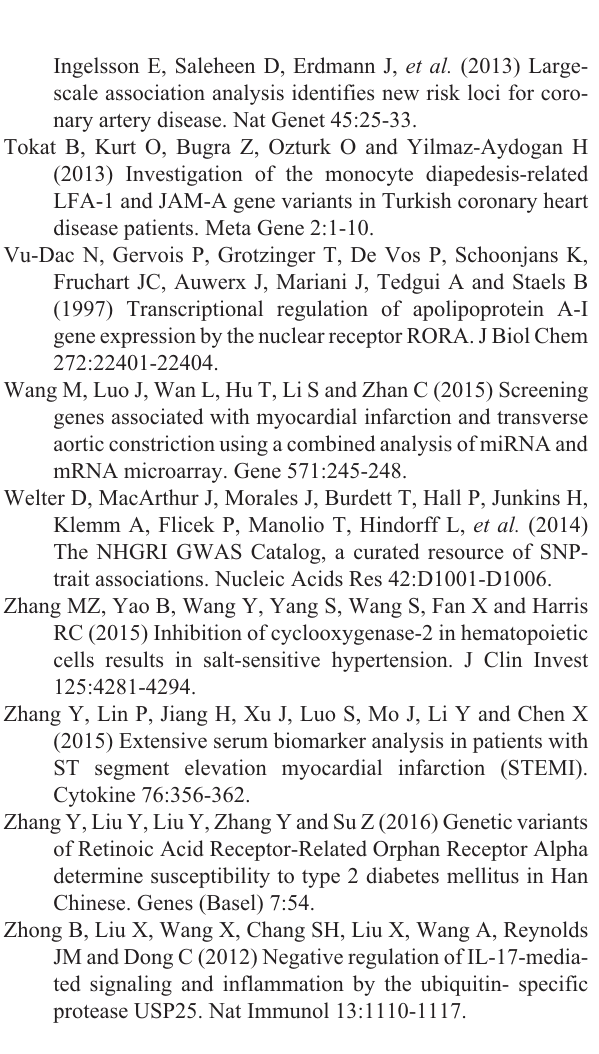
Table S1 - GO analysis – Cellular localization. Table S2 - GO analysis – Biological process. Table S3 - GO analysis – Molecular function. Table S4 -Main KEGG